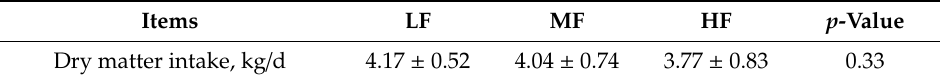
Table 2. Feed intake in adult donkeys fed low- (LF, F / C = 35:65), medium- (MF, F / C = 55:45) and high-fiber (HF, F / C = 80:20) diets with di ff erent forage / concentrate ratios (F /